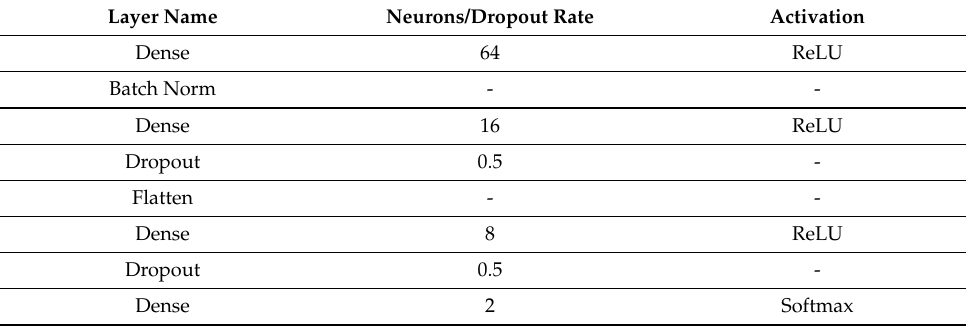
Table 3. MLP architecture with learning rate set to 10 − 4 .